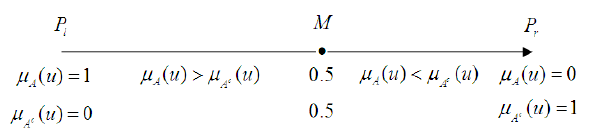
Fig. 1. The relation of the relative membership degree function